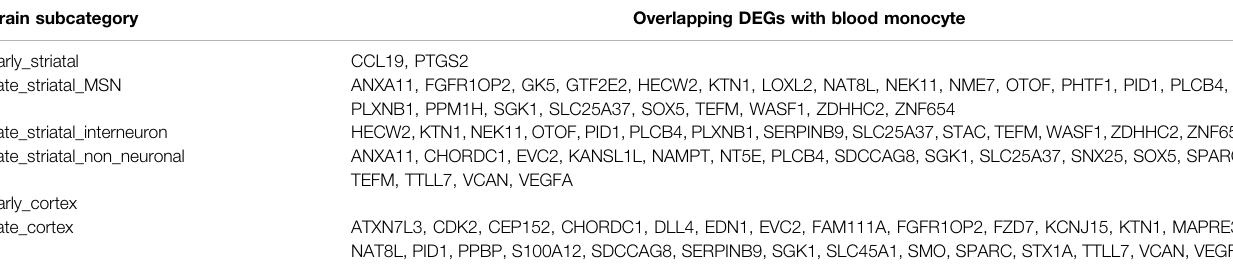
TABLE 3 | Overlapping differentially expressed genes (DEGs) with blood monocyte DEG list in each brain subcategory. The table shows common DEGs between blood monocytes and the six brain subcategories. No common DEGs between early_cortex dataset and blood monocytes. Brain subcategory Overlapping DEGs with blood monocyte